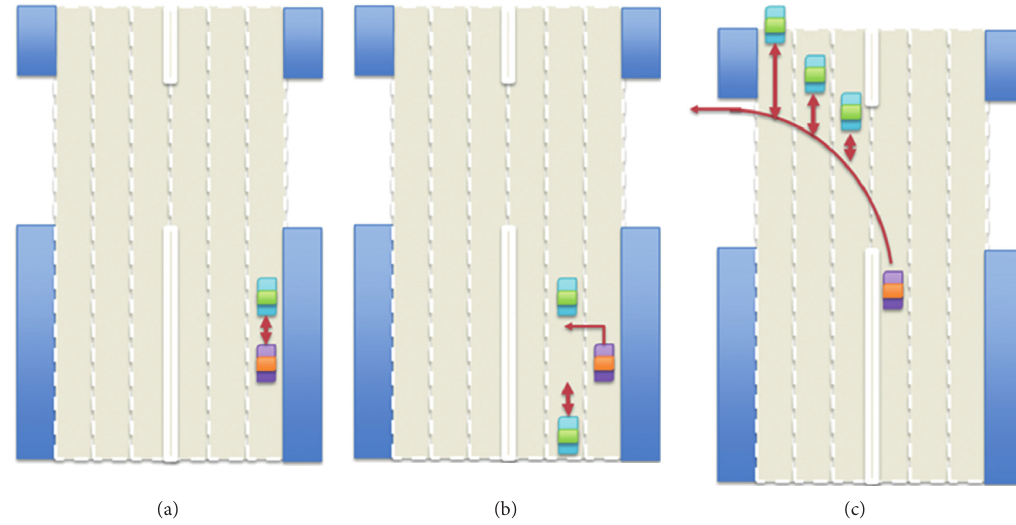
Figure 3: Gap acceptance for car-following (a), lane-changing (b), and left-turning (c) in the All-knowing driving logic.